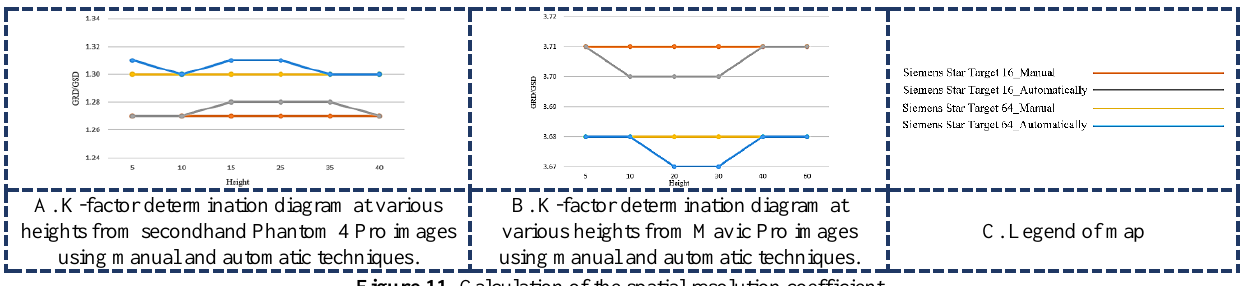
Figure 11. Calculation of the spatial resolution coefficient.